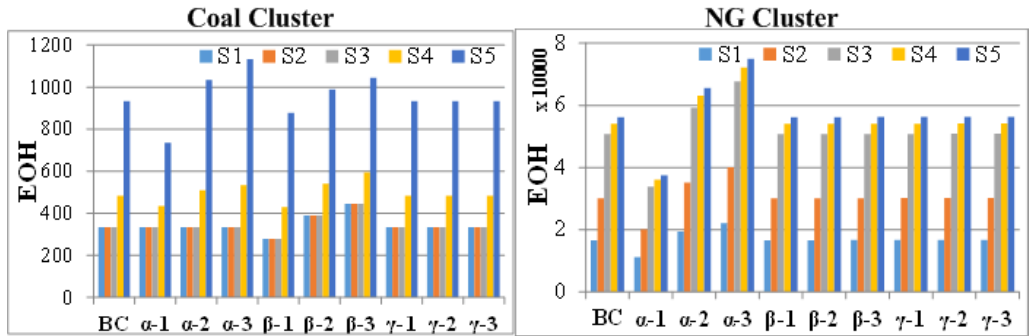
Figure 5. EOH of the units from coal and natural gas cluster for different scenarios and cases.